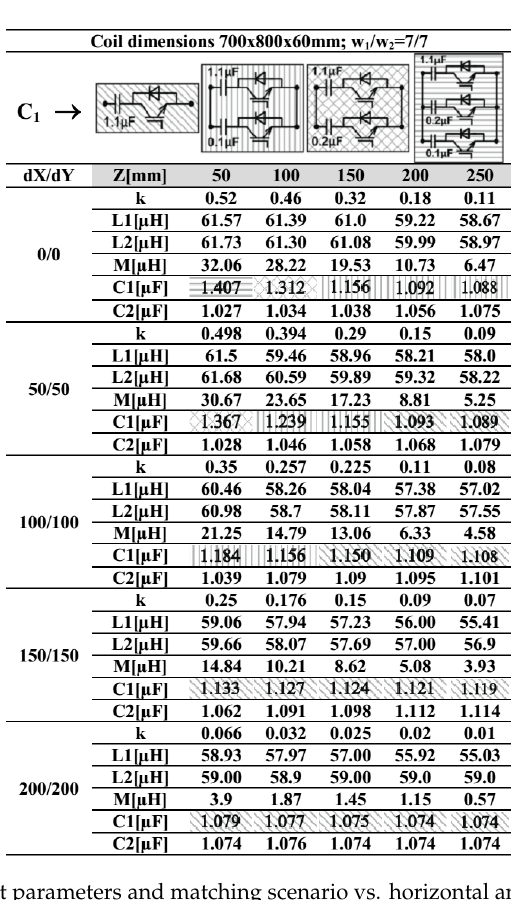
Figure 13. IPT equivalent parameters and matching scenario vs. horizontal and vertical misalignment.